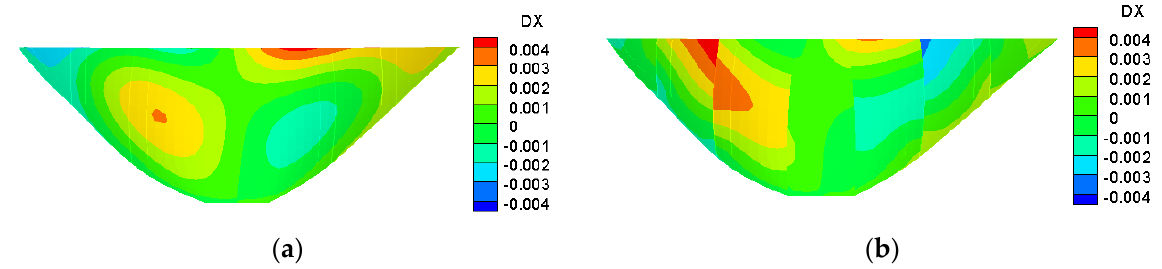
Figure 15. The distribution of transverse displacement on the arch-dam upstream surface of different transverse joint models. ( a ) M1. ( b ) M2.